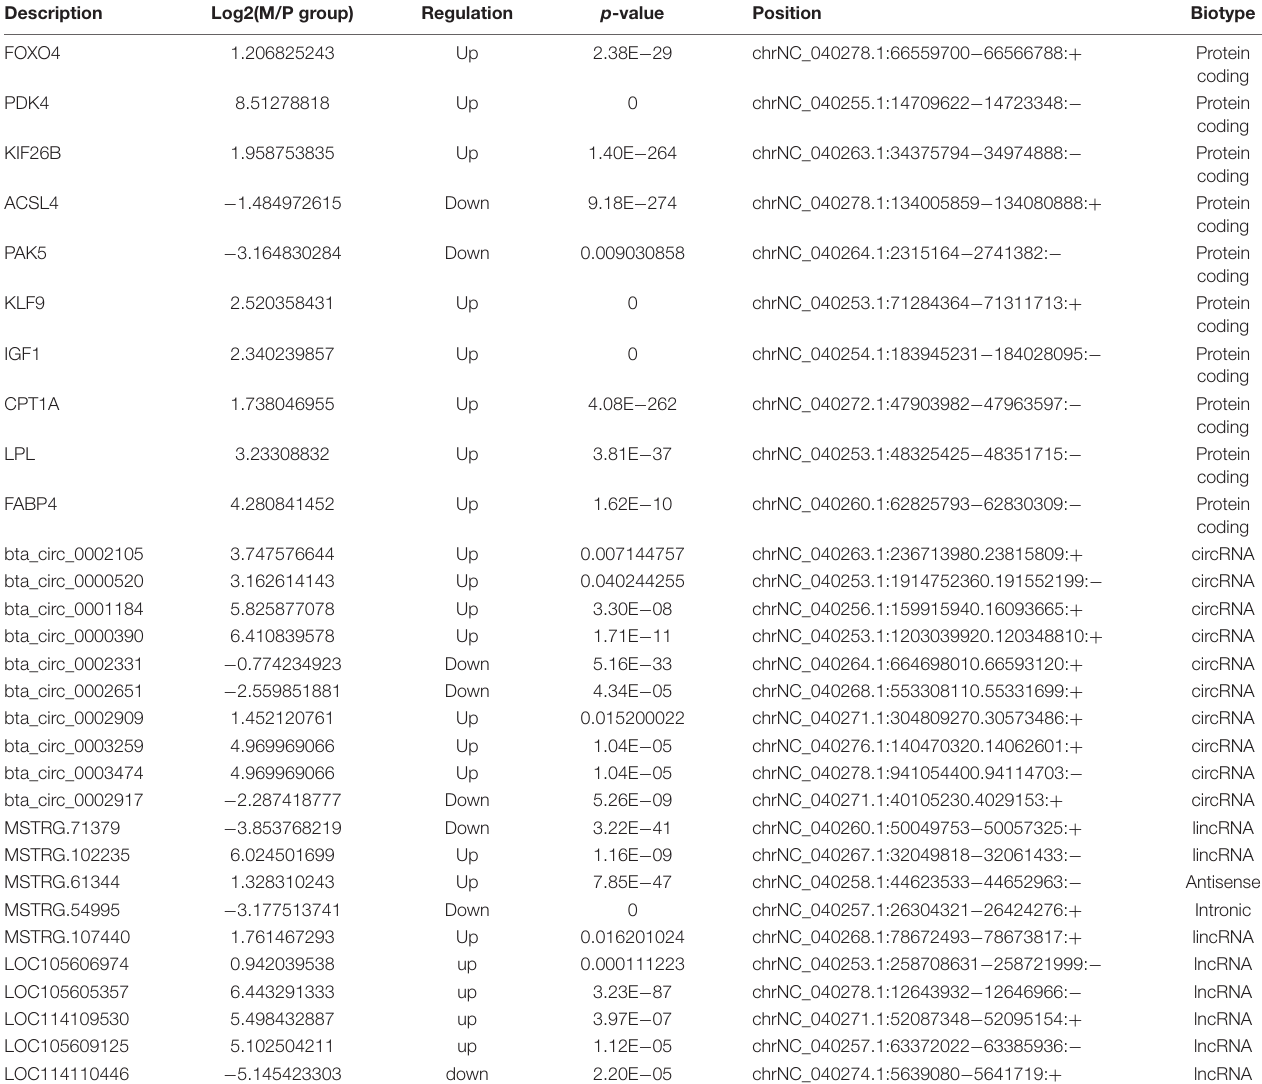
TABLE 6 | Validation DERs by qPCR.